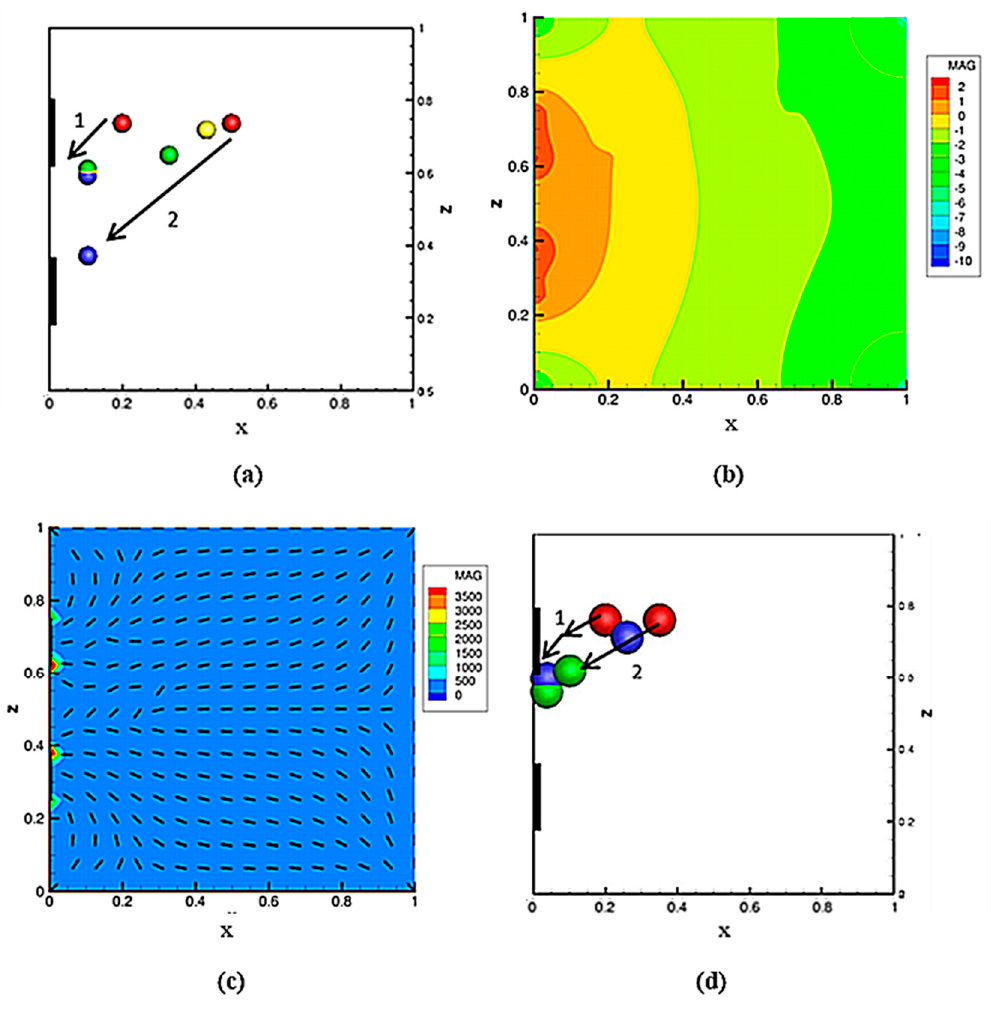
Figure 3. The DEP force induced the motion of two particles in the xz -plane for ε p = 1.2. ( a ) The diameter of particles is 0.2. The initial positions of the two particles, shown by red circles, are (0.2, 0.25, 0.88) and (0.5, 0.25, 0.88). The final positions are shown using blue circles. Notice that, for clarity, the circles used to show the particles are smaller than the actual particle size. ( b ) Isovalues of log| E |; the particles are at their initial positions. Notice that the electric field is modified from that in Figure 1 because of the presence of particles. ( c ) Magnitude and direction of ∇ E 2 ; the particles are at (0.11, 0.25, 0.6) and (0.23, 0.25, 0.6). Notice that the direction of the DEP force is no longer symmetric about the domain midplane. ( d ) The diameter of particles is 0.05. The initial positions of the particles, shown by red circles, are (0.2, 0.25, 0.88) and (0.5, 0.25, 0.88). The final positions are shown using blue circles. Notice that in this case both particles collected at the upper